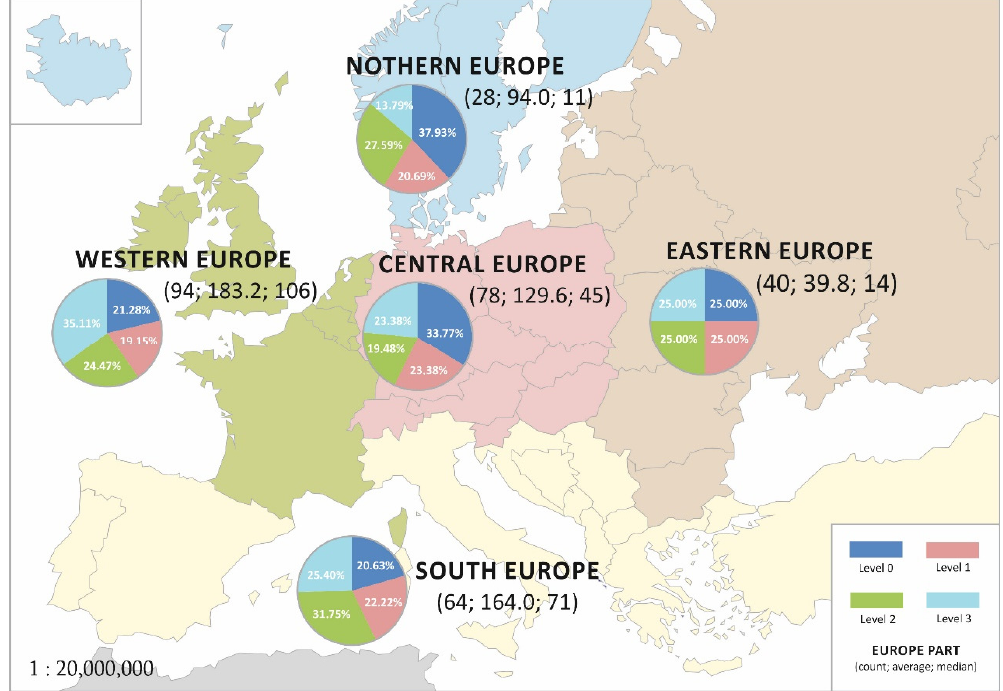
Figure 2. Results of statistical analysis for the number of meetings in the studied promotional events, depending on the European region in which the event took place. Source: own study.